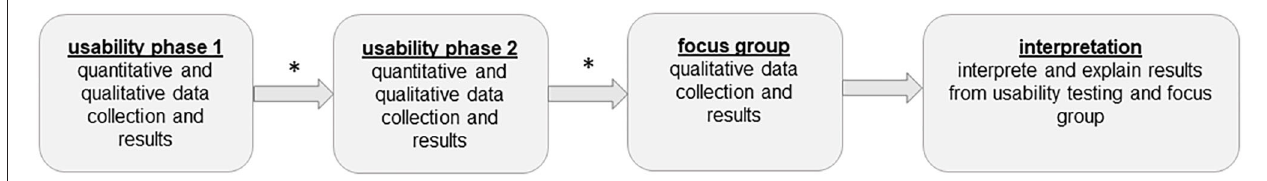
FIGURE 1 | Explanatory design. *after each usability phase the app was revised based on the feedbacks from the participants.